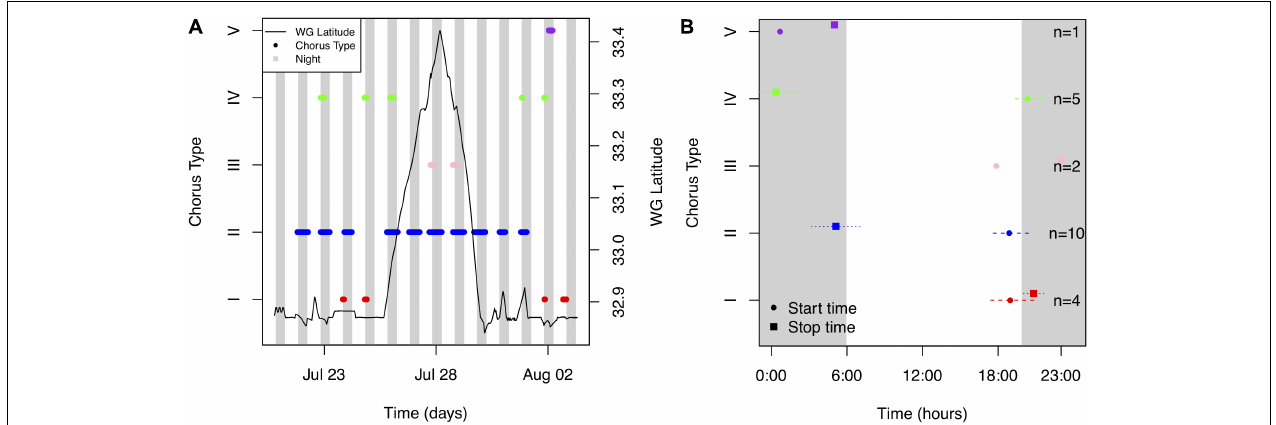
FIGURE 4 | (A) Occurrence of five fish choruses [red (Type I), blue (Type II), light pink (Type III), green (Type IV) and purple (Type V) dots] as a function of time (days) and latitude during the entire deployment. The latitude of the Wave Glider (WG) over time is shown as a solid black line. (B) The mean and standard deviation of start (circles) and end (squares) times of each chorus. The sample size ( n ) is shown. The time between sunset and sunrise (i.e., night) is shaded gray. Times are reported in Pacific Standard Time.